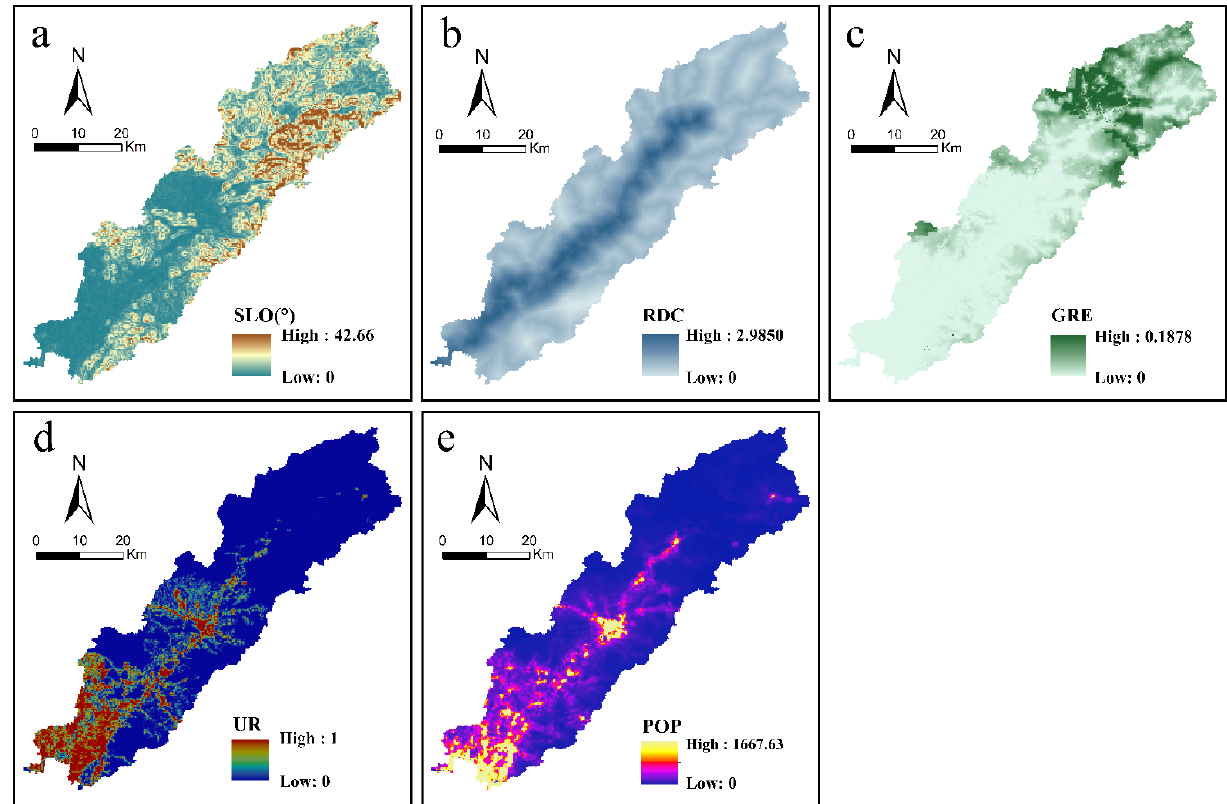
Figure 2. Spatial distribution of five factors in 2018: ( a ) SLO, slope; ( b ) RDC, river distance accessi- bility; ( c ) GRE, per capita green area; ( d ) UR, the proportion of urban; ( e ) rural human settlements, POP, population.